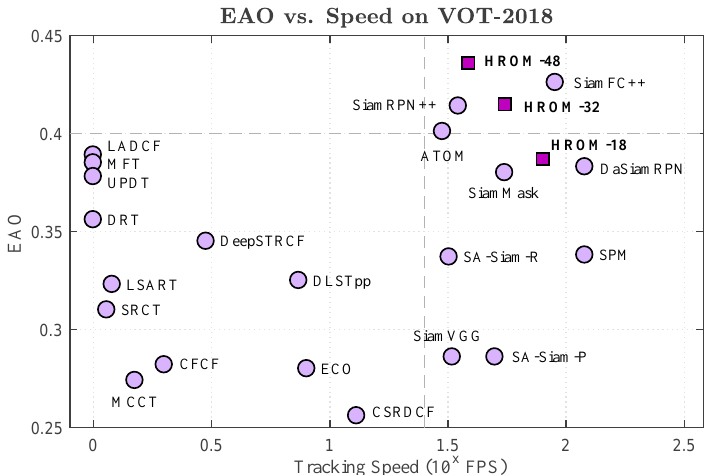
Figure 5. A comparison of the EAO scores and the speed with state-of-the-art tracking methods on VOT-2018